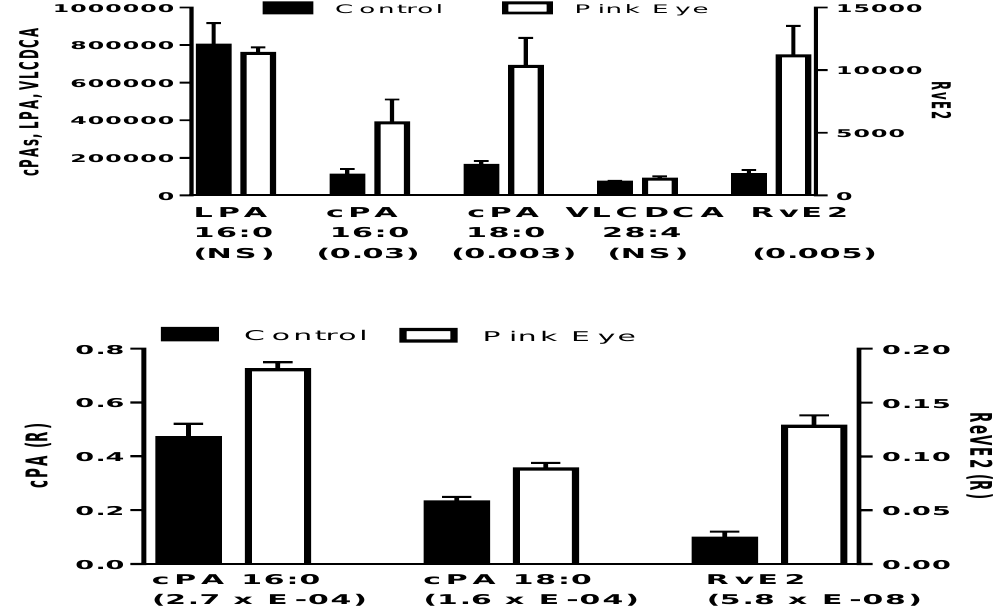
Figure 1. Potential anti-inflammatory biomarkers in bovine tear fluid. In the upper graph data are presented as peak intensities for the product ions (MS 2 ) of each of the lipids ± SEM. In the lower graph, product ion data are presented as the ratios (R) of the endogenous lipid peak intensity to the peak intensity of 500 pmoles of [ 2 H 4 ]cPA 16:0. cPA, cyclic phosphatidic acid; LPA, lysophosphatidic acid; RvE2, resolvin E2; VLCDCA, very-long-chain dicarboxylic acid. p values are in brackets.